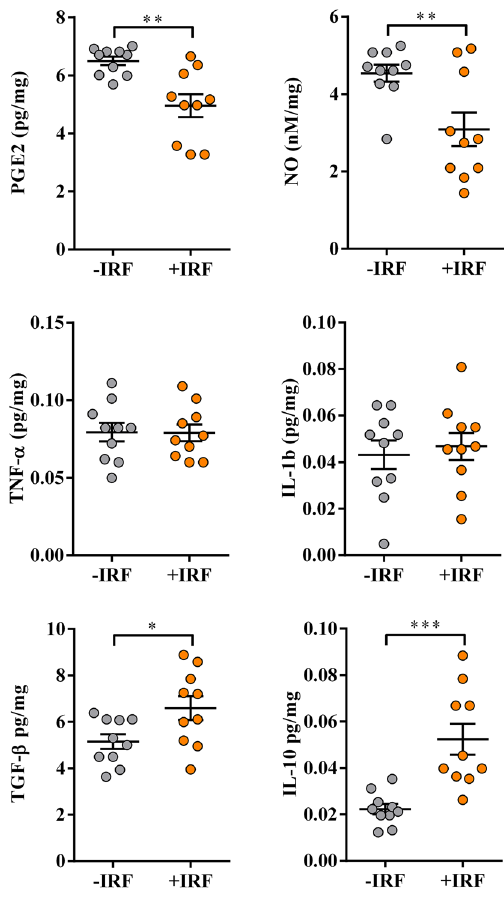
Figure 5. Influence of exposure to IR fibres on the production of PGE 2 , NO and cytokines by inflamed paws from CIA-affected rats. Scatter plots (created using GraphPad Prism version 7.00 for Windows, GraphPad Software, La Jolla, California, USA; https ://www.graph pad.com) show PGE 2 , NO, TNF-α, IL-1β, TGF-β and IL-10 production levels in the supernatants from 4 h (PGE2) and overnight hind paw tissue cultures (normalized to the paw weight) (see “Material and methods”) from CIA rats were housed in cages with IR fibre bedding (+IRF) and their counterparts housed in cages with standard wooden shaving bedding (−IRF rats). Rats were transferred to cages with IR fibre bedding five days before immunization. Hind paws were excised from CIA rats on the 22nd day post immunisation. Results are expressed as mean ± SEM. n = 10 rats/group. * p ≤ 0.05, ** p ≤ 0.01 and *** p ≤